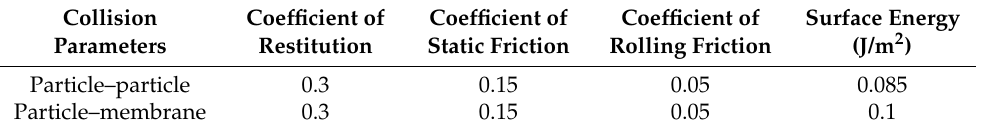
Table 2. Collision parameters.